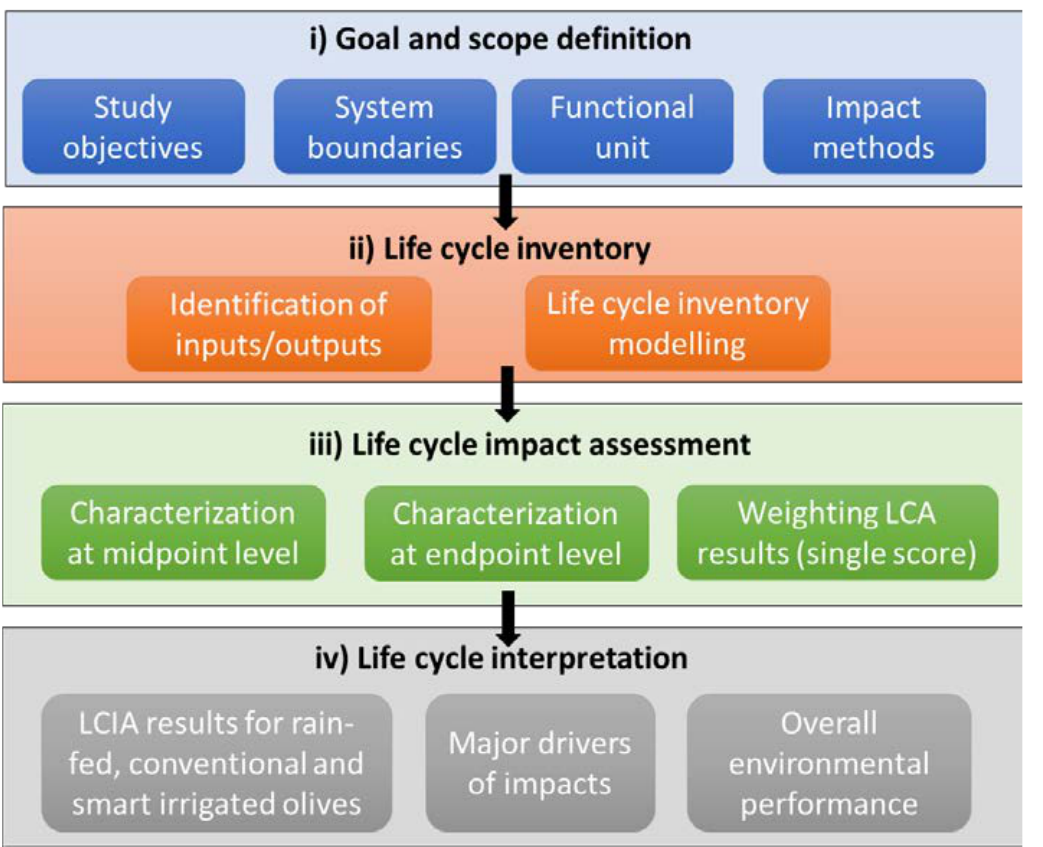
Figure 2. Diagram of the LCA framework used in this study.